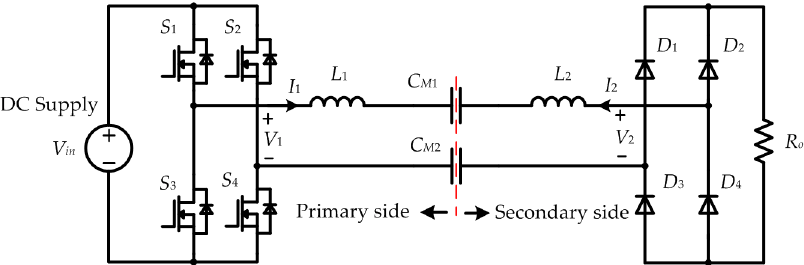
Figure 15. Circuit topology of a CPT system based on full-bridge inverter with double-sided L compensation.